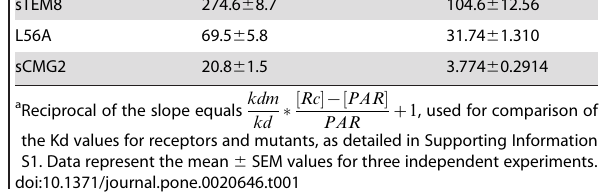
Table 2. In vivo protection against intoxication provided by different receptor decoys.